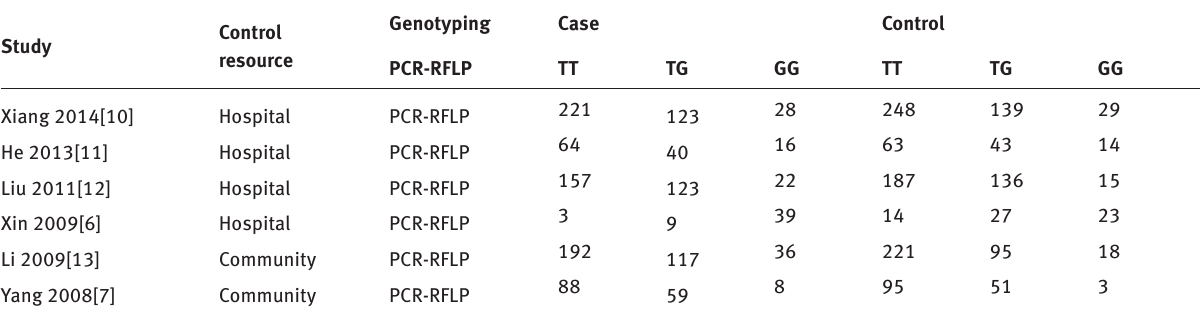
Table 1: The main information of the studies included in this meta-analysis